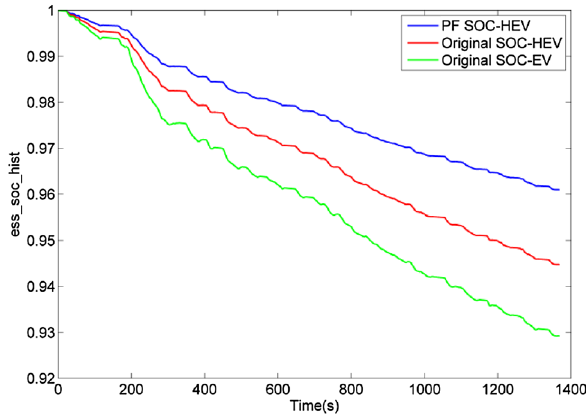
Fig. 9 SOC consumption of power battery under NEDC